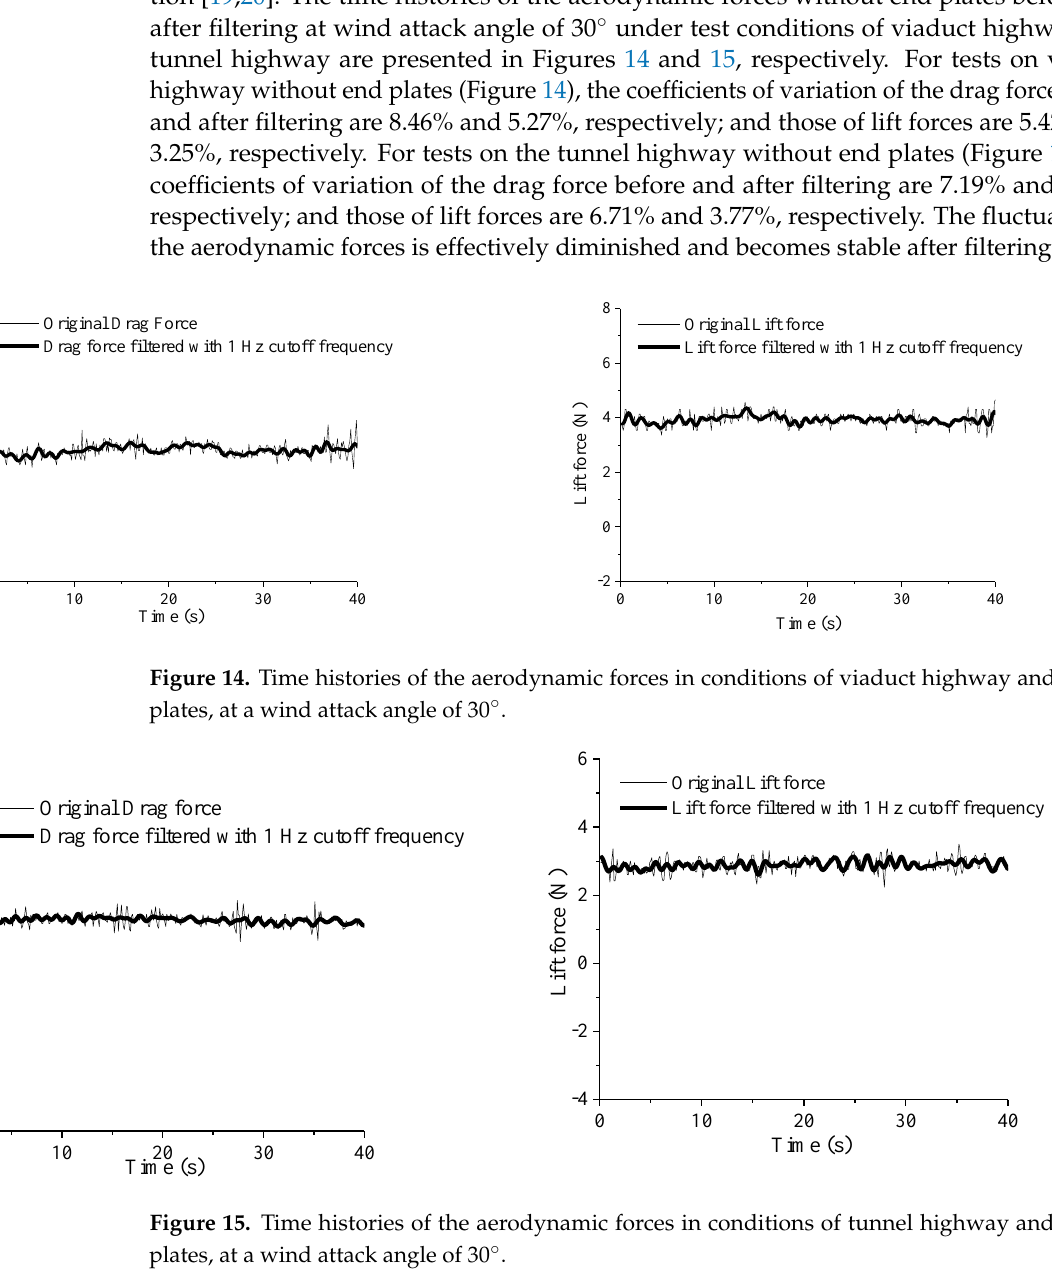
α (°) Figure 16. Comparisons of the aerodynamic coefficients of the test model with end plates measured by the wind tunnel test and transiting tests.